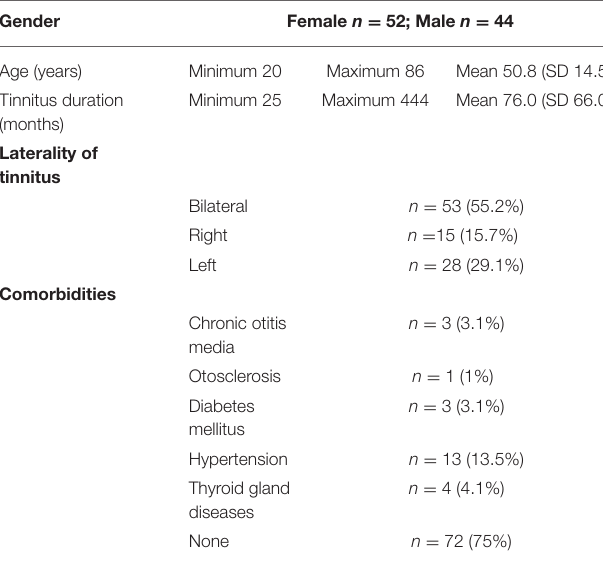
TABLE 1 | Description of 96 participants.